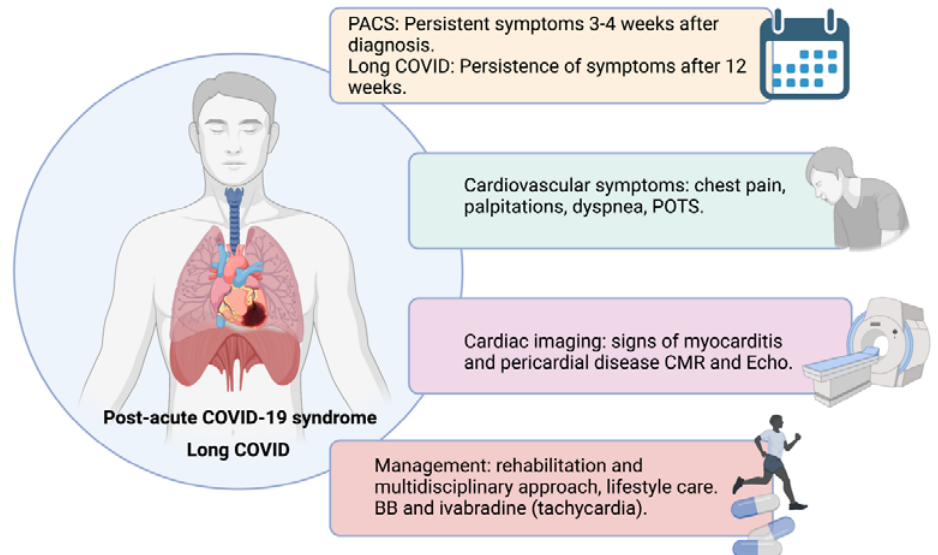
Figure 4. Post-acute COVID-19 syndrome (PACS) and Long COVID key points. BB, beta blockers; CMR, cardiac magnetic resonance; POTS, postural orthostatic tachycardia syndrome.